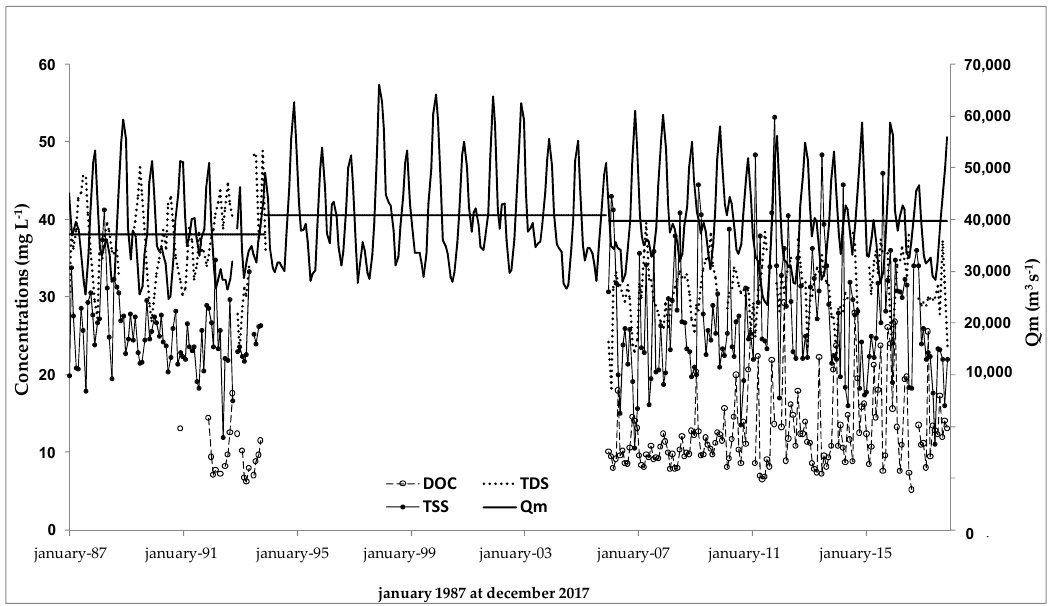
Figure 4. The interannual variation of monthly discharge (Qm) and concentrations of total suspended sediment (TSS), total dissolved solids (TDS) and dissolved organic carbon (DOC) of the Congo River at Maluku Trechot for 1987–1993 (PEGI/GBF program) and at Brazzaville/Kinshasa for the 2006–2017 period (SOH program). Monthly DOC values are from December 1990 to October 1993 and during